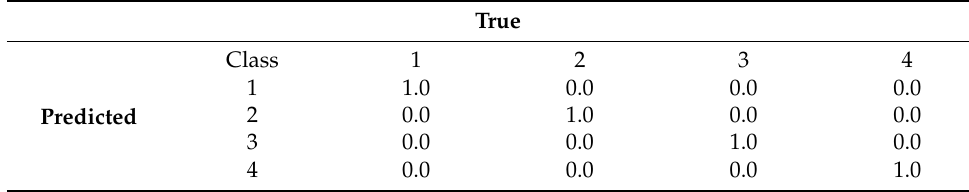
Table 3. Confusion matrix of the color recognition